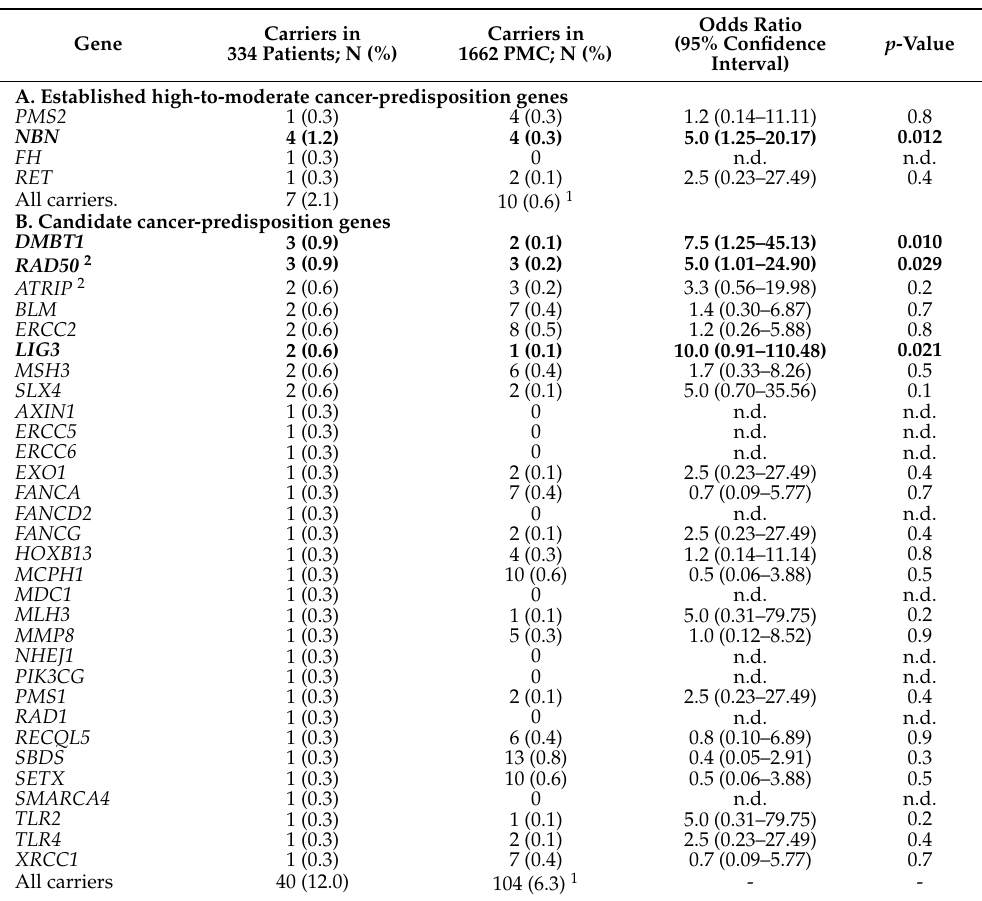
Viral, HCC recurrence post ‐ Tx